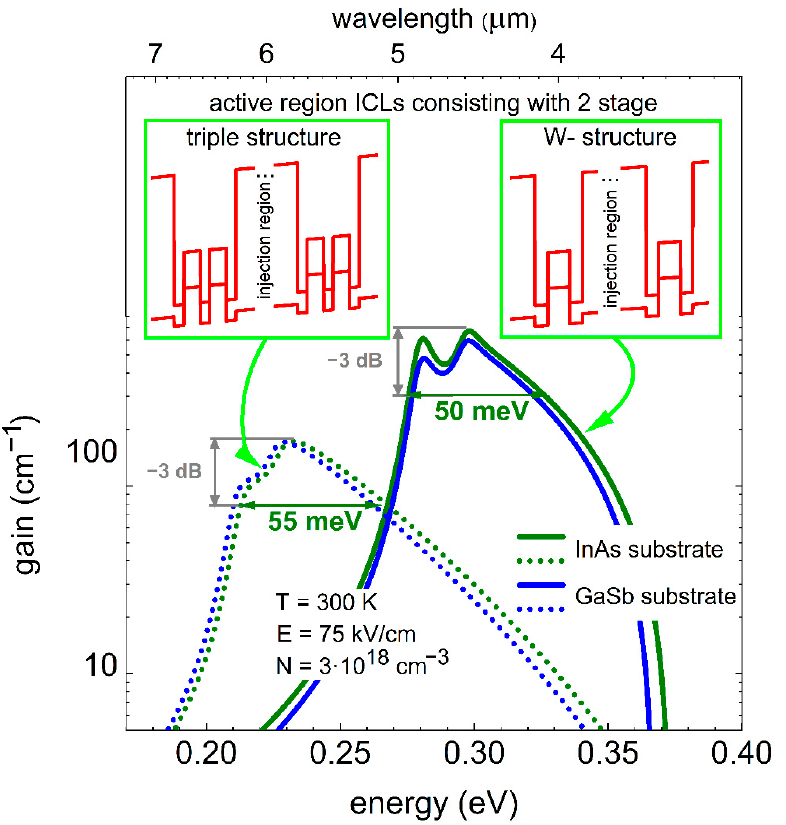
Figure 3. Optical gain functions for different active region consisting of 2 stages with a W-structure (solid line) made of AlSb/InAs(2.0 nm)/Ga 0.76 In 0.24 Sb(3.5 nm)/InAs(2.0 nm)/AlSb and AlSb/InAs(2.1 nm)/Ga 0.76 In 0.24 Sb(3.5 nm)/InAs(2.1 nm)/AlSb and triple structure (dotted line) con- sisting of AlSb/InAs(2.0 nm)/Ga 0.76 In 0.24 Sb(3.5 nm)/InAs(2.0 nm)/Ga 0.76 In 0.24 Sb(3.5 nm)/InAs(2.0 nm)/AlSb and AlSb/InAs(2.1 nm)/Ga 0.76 In 0.24 Sb(3.5 nm)/InAs(2.1 nm)/Ga 0.76 In 0.24 Sb(3.5 nm)/InAs(2.1 nm)/AlSb. Blue and green lines refer to structures deposited on GaSb and on InAs, respectively.